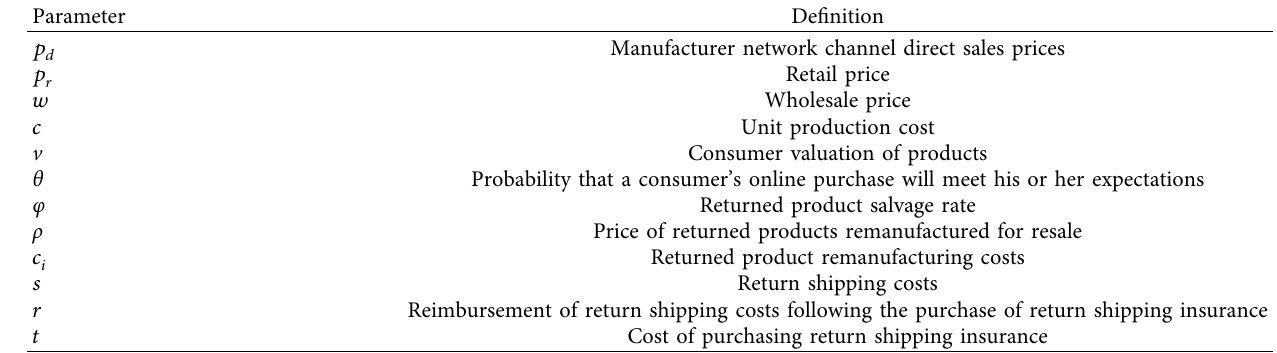
Table 2: Summary of